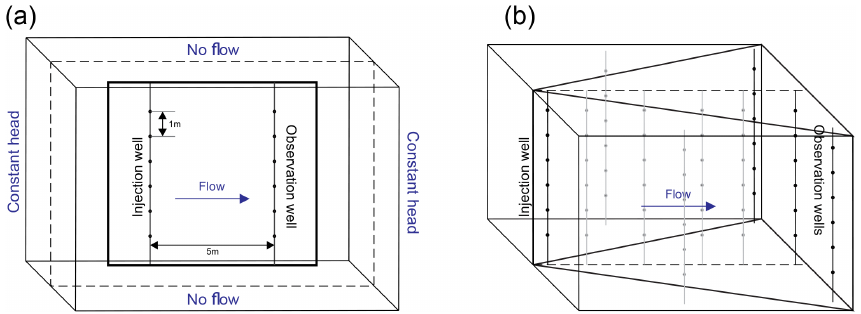
Figure 4. (a) Simulated experimental configuration and numerical model boundary conditions. The tomographic setup consists of six sources in the injection well and six receivers in the observation well. (b) Setup of the 3-D experiment with one injection and three observation wells. Additional wells used for validation are marked in